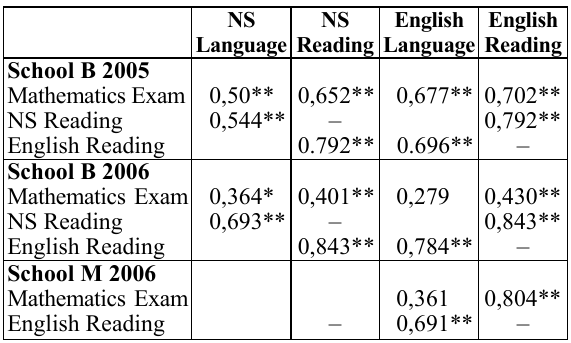
Table 3: Correlations between mathematics, language and reading comprehension in NS and